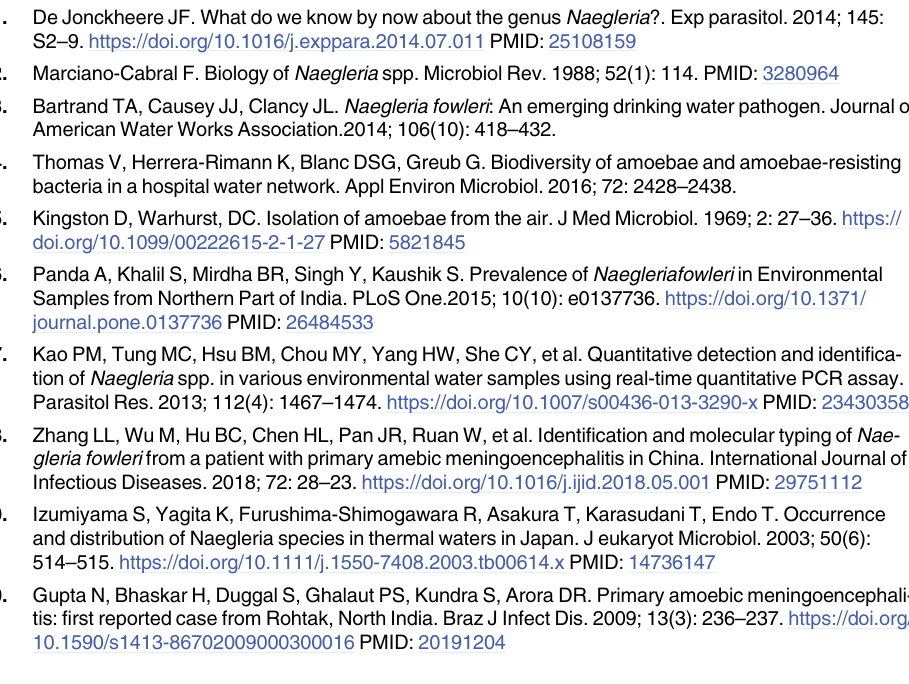
S1 Table. GIS readings, temperature, pH, and turbidity values of Naegleria PCR positive